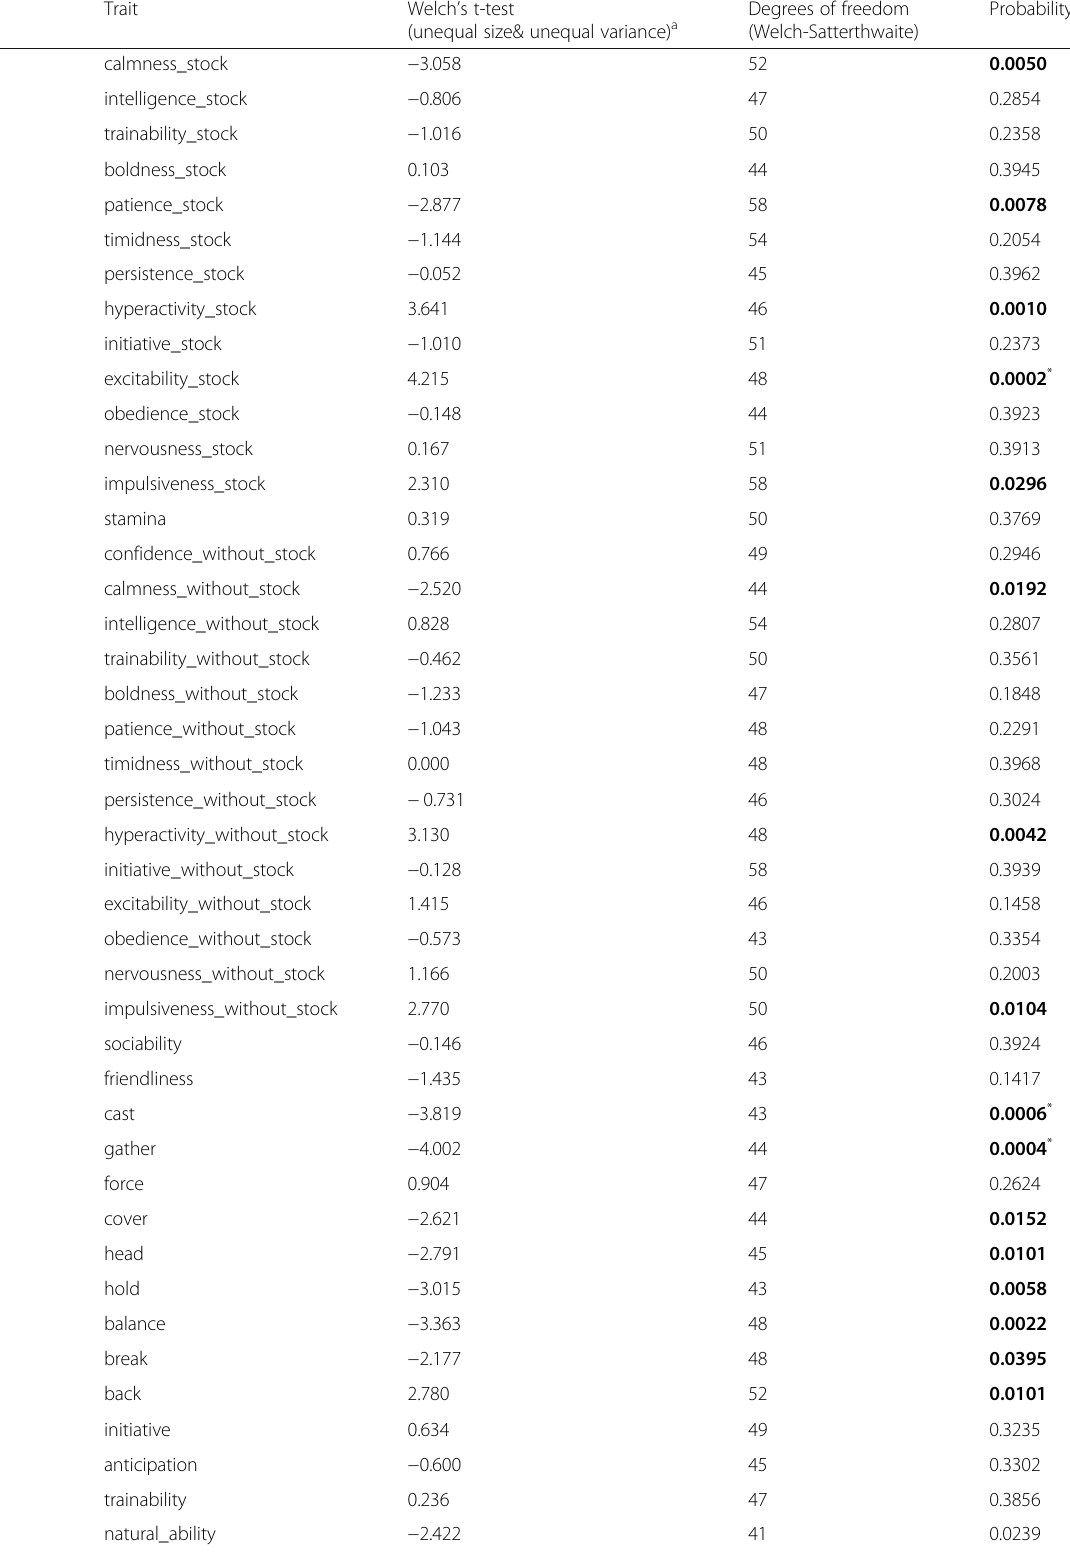
Table 1 Pairwise comparison of work-type in the Australian Working Kelpie over 63 traits (Continued)